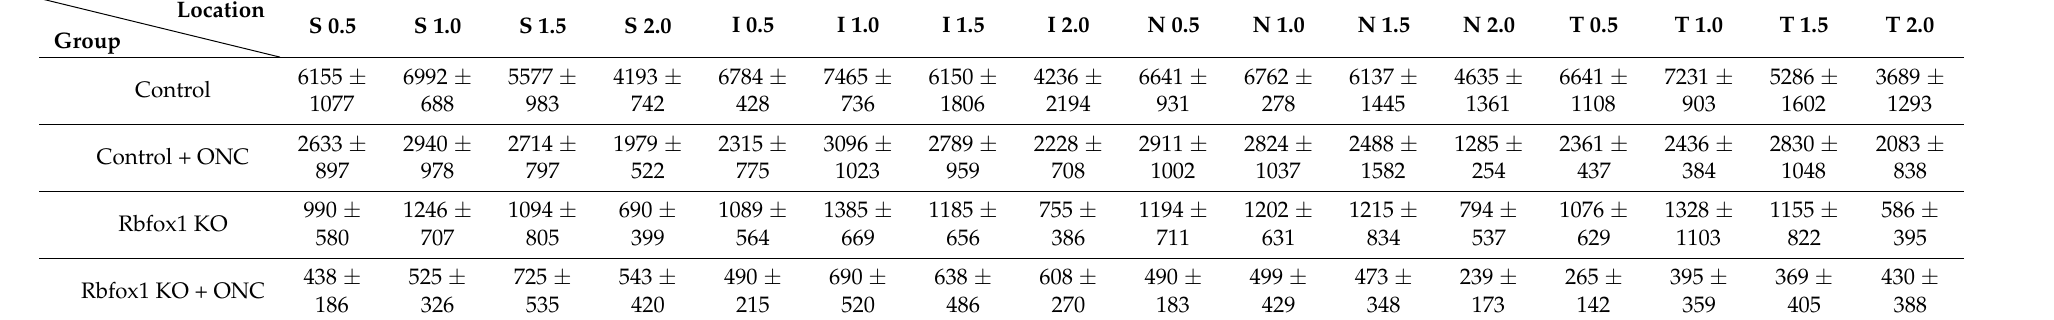
Table 2. Densities of Rbfox1/Rbpms-positive cells in retinas of control and Rbfox1 KO animals with and without ONC (per mm 2